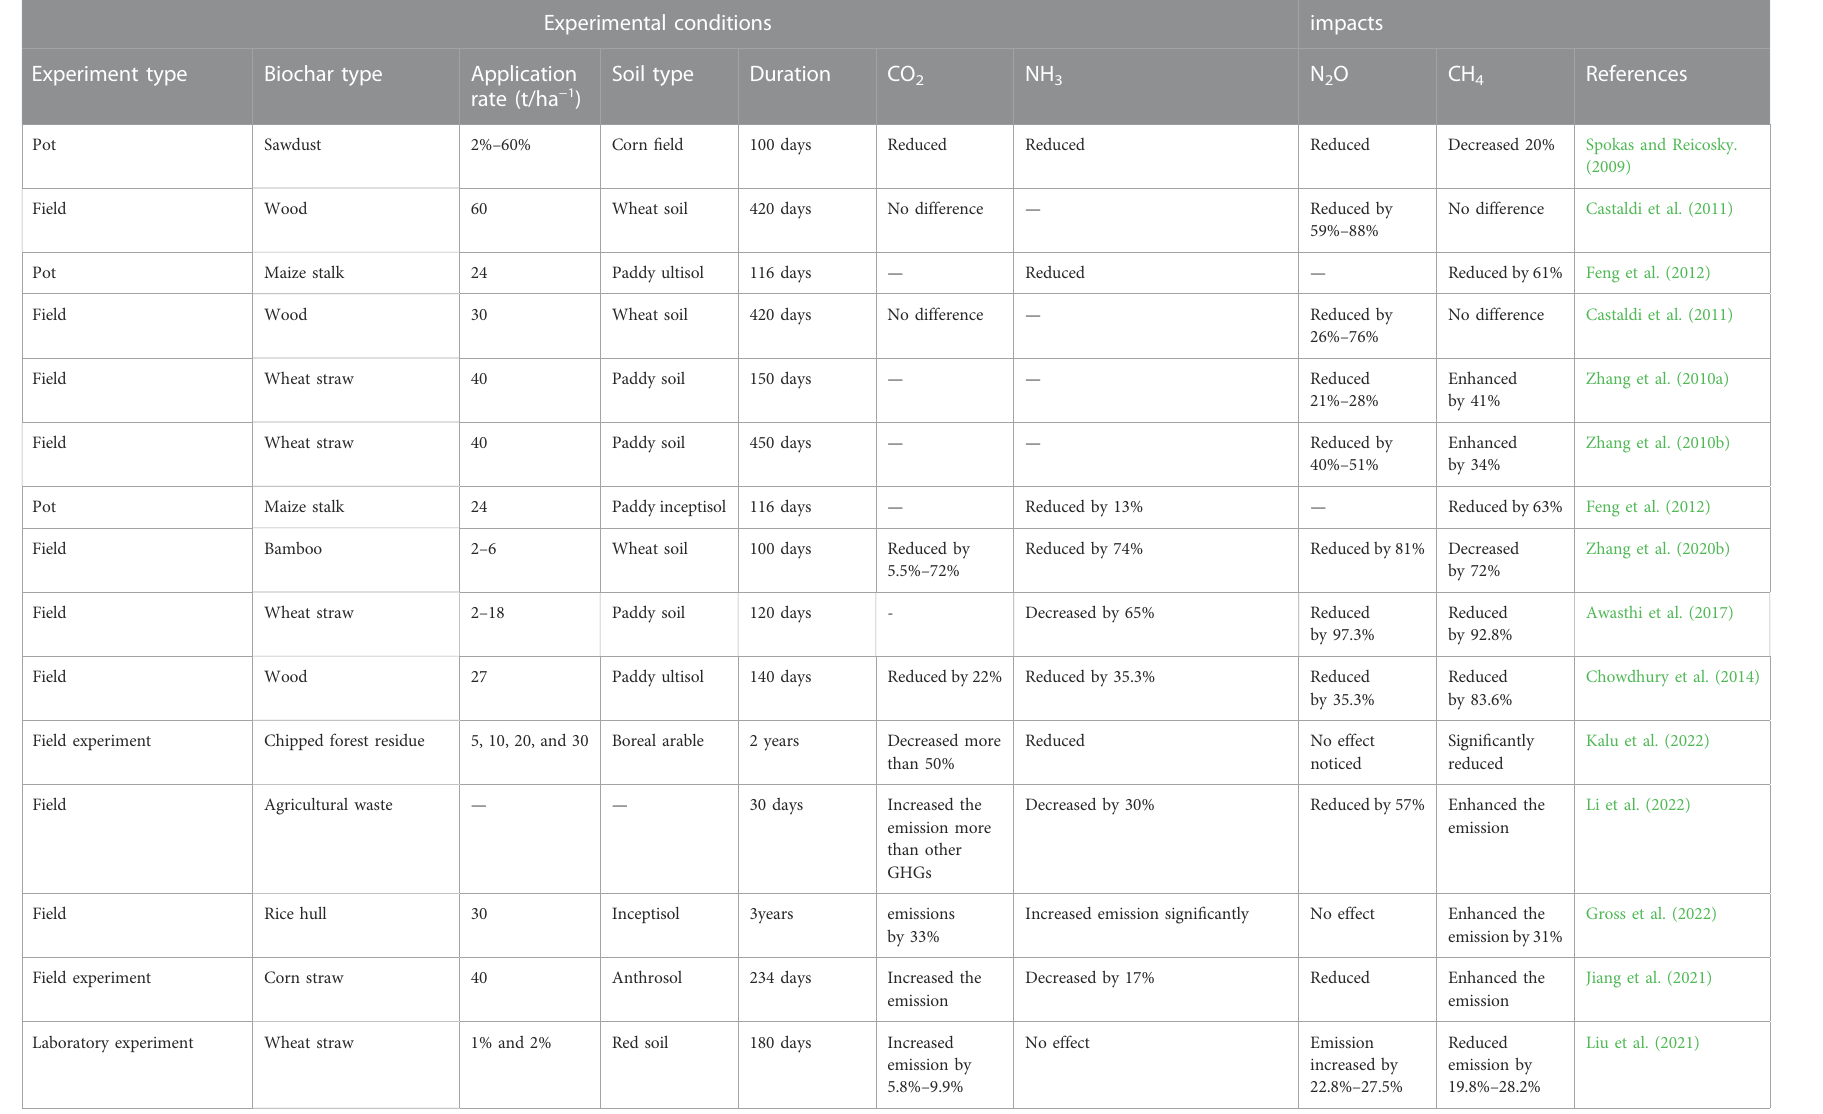
TABLE 8 Effect of biochar addition on carbon sequestration and GHGs